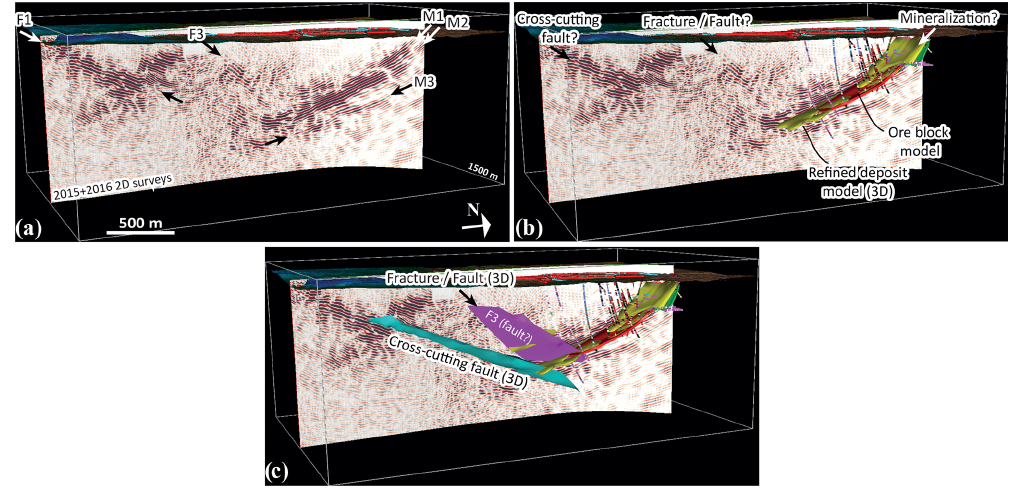
Figure 14. A set of 3D views from (a) the earlier 2D surveys (Markovic et al., 2020) and (b) interpretation of the main features in the 2D profile (along P1 of the 3D survey) and (c) how various features extracted from the 3D volume manifest themselves in this 2D profile result. In particular, note that the F1 and M3 are better defined in the 3D volume (Figs. 12 and 13), showing a westward plunge for F1 and a submerging character for M3, implying they have a major out-of-the-plane nature in the 2D